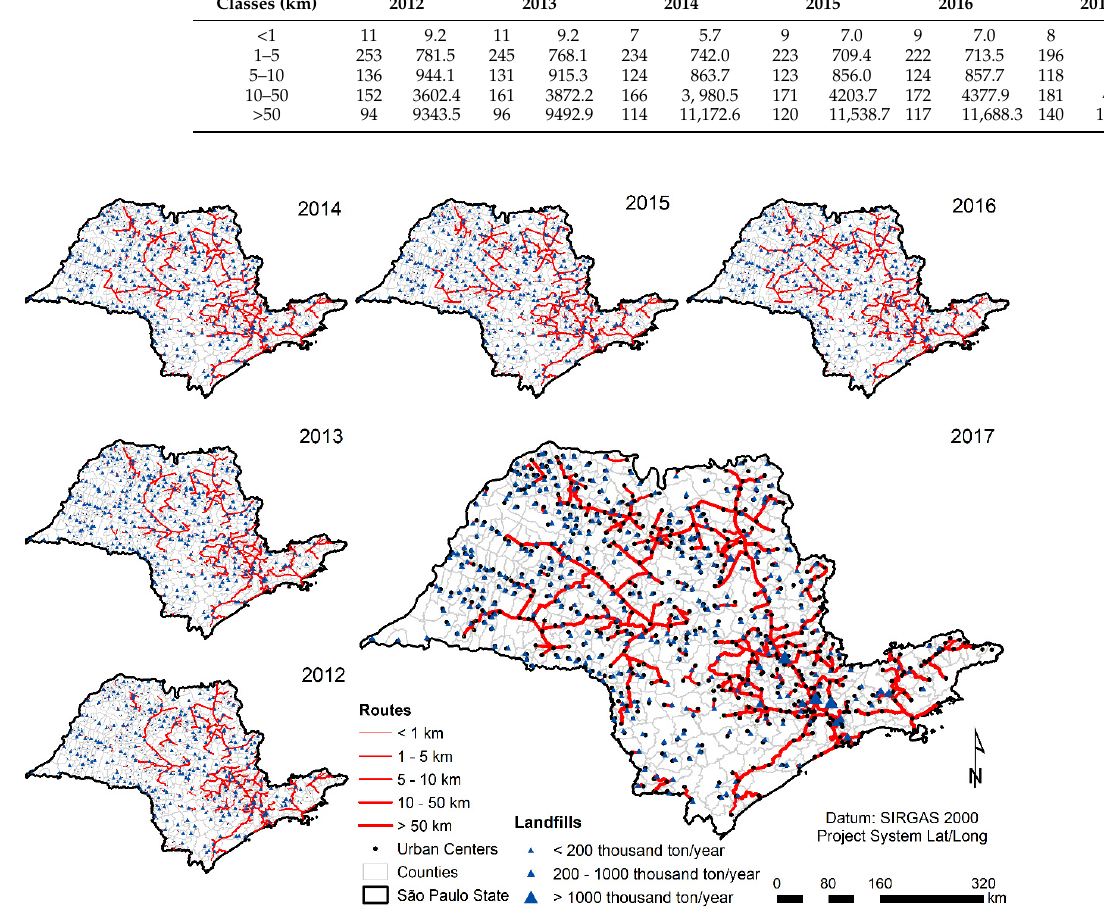
Figure 3. Sao Paulo state's municipalities MSW truck's vehicles routes from 2012 to 2017.